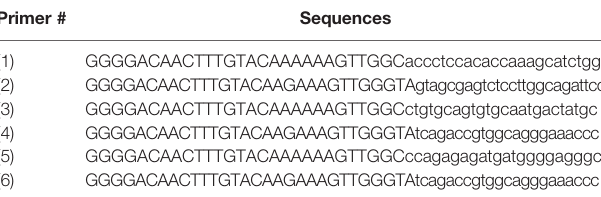
TABLE 2 | Primers used to generate deletion derivatives of the ESR1